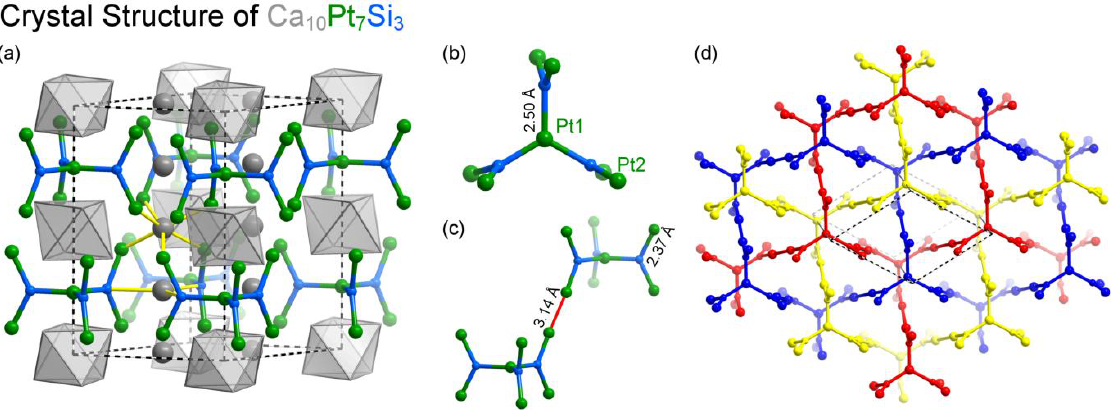
Si trefoil 7 3 Si units; 7 3 Si 7 3